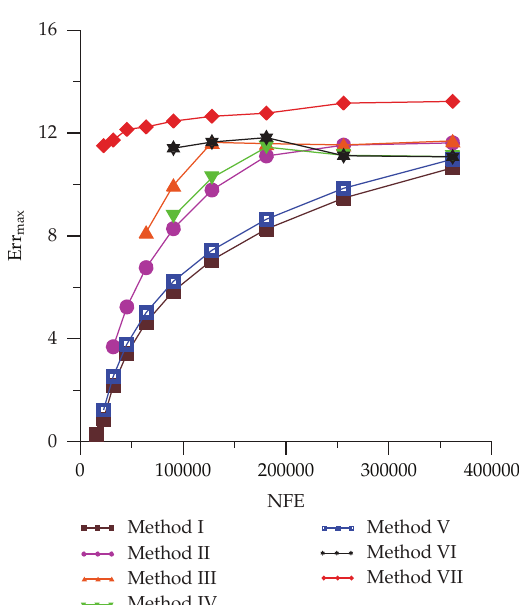
Figure 3: Err max for several values of the number of function evaluations (cid:4) NFE (cid:7) for the Methods I–VII for the nonlinear orbital problem. The nonexistrnce of a value of Err max indicates that for these values Err max is